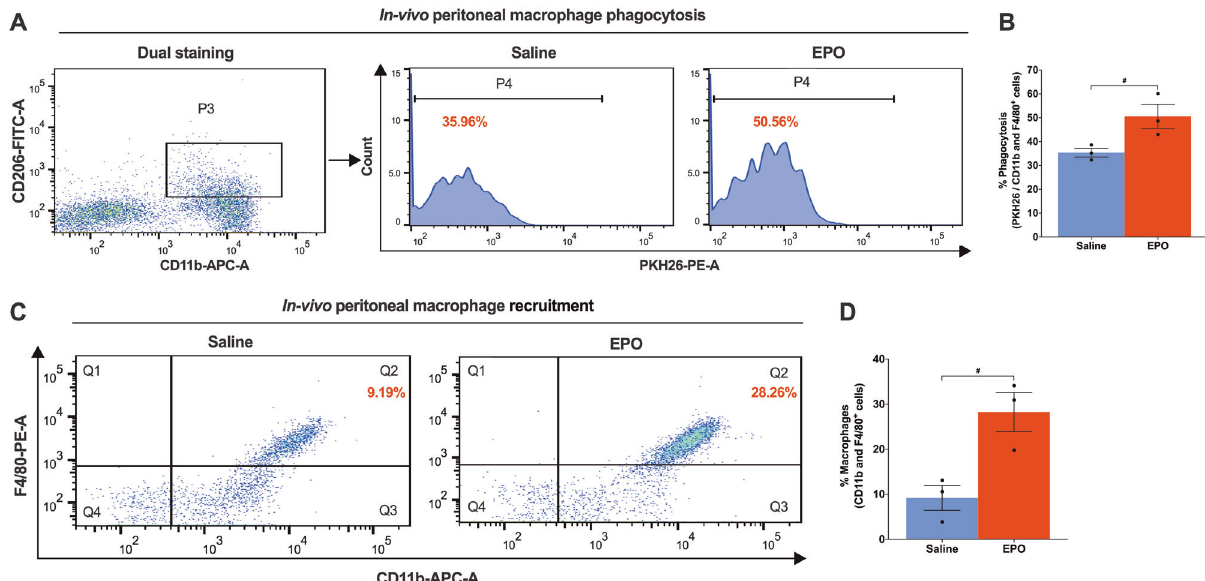
Fig. 8 EPO treatment augments M2 phenotype peritoneal macrophage phagocytosis, in vivo. A Flow cytometry gating strategy of dual staining (CD11b + CD206 + ), where that shows (P4, histogram) EPO treatment (5000 IU/kg/IP, immediately after surgery and on post-surgery day 1 and 2) signi fi cantly augments percent phagocytosis of intraperitoneally injected apoptotic SNSCs (PKH26 labeled) as compared to saline treatment (normal saline, 0.1 ml/IP/mouse) and the results are denoted in the bar graph ( B ). C Flow cytometry data shows EPO signi fi cantly recruits PMØs (CD11b + F4/80 + ) following intraperitoneal injection of apoptotic SNSCs (PKH26 labeled) as compared to saline treatment and the results are denoted in the bar graph ( D ). Unpaired t -tests. Data were expressed as means ± SEM, # P < 0.05, Saline vs. EPO, n =